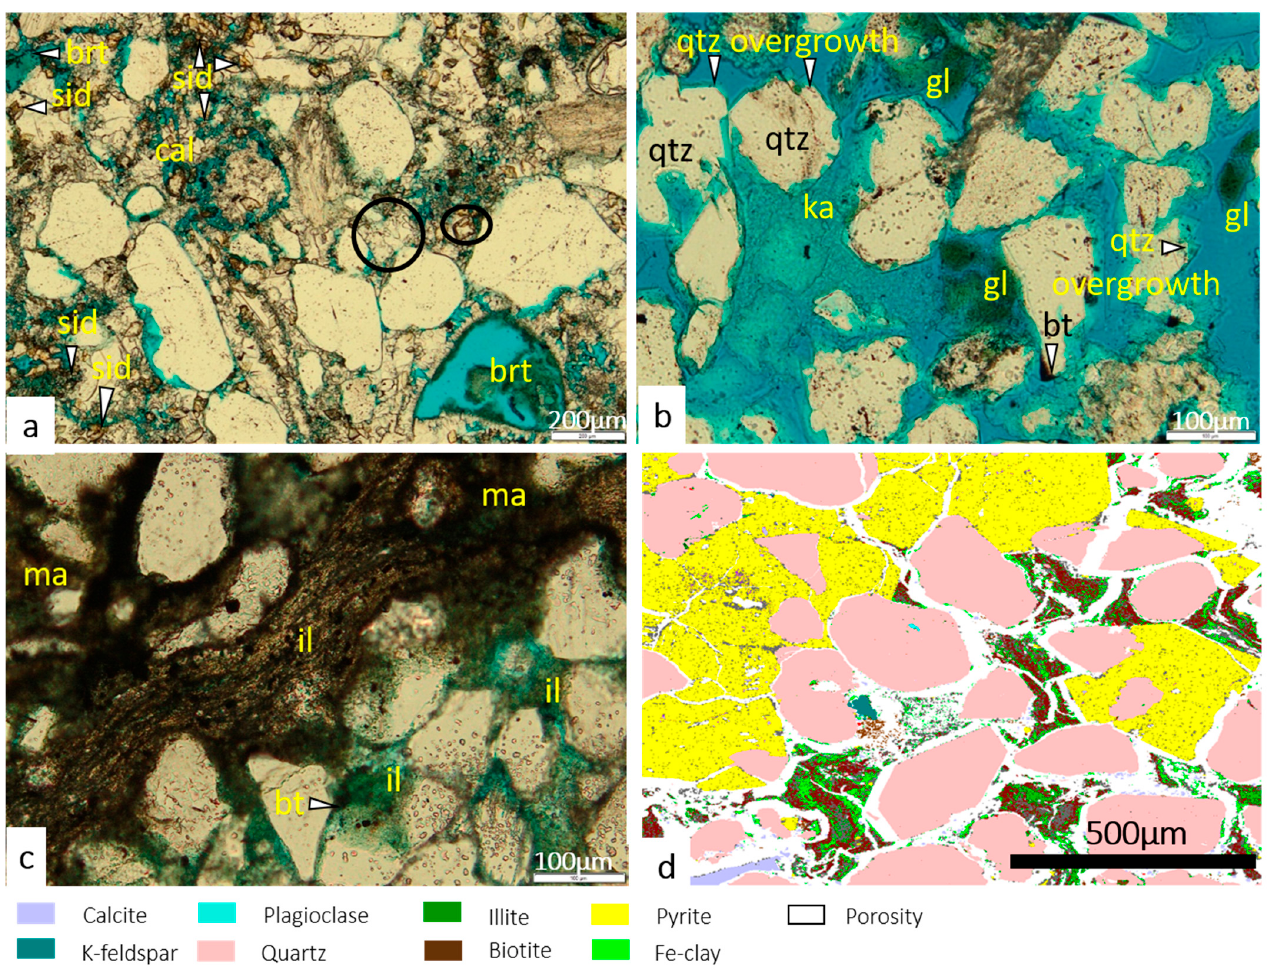
Figure 8. ( a ) is a photomicrograph from PW7 (1130.05 m MD) showing calcite cement, siderite filling moldic pores from Fe-ooid dissolution (bottom-left), berthierine replacing an Fe-ooid (bottom-right) and pore-filling dolomite (circled in black). ( b ) PW7 (1136.52 m MD): is a high intergranular porosity sample with authigenic illite and kaolinite in pore spaces. Quartz overgrowths project from grain surfaces into pore spaces thereby reducing porosity. ( c ) BL5 (2206.8 m MD): muscovite replaced by illite with pore-filling illite at the bottom centre. ( d ) PW7 (1123.19 m MD): is an SEM-EDS image with pore-filling pyrite and Fe-clay in a biotite rich matrix. The biotite and Fe-clay occur together which might suggest a genetic relationship. Definition of abbreviations used on the images: quartz grain (qtz), glauconite (gl), calcite cement (cal), siderite (sid), berthierine (brt), illite (il), kaolinite (ka), glauconite (gl), matrix (ma).